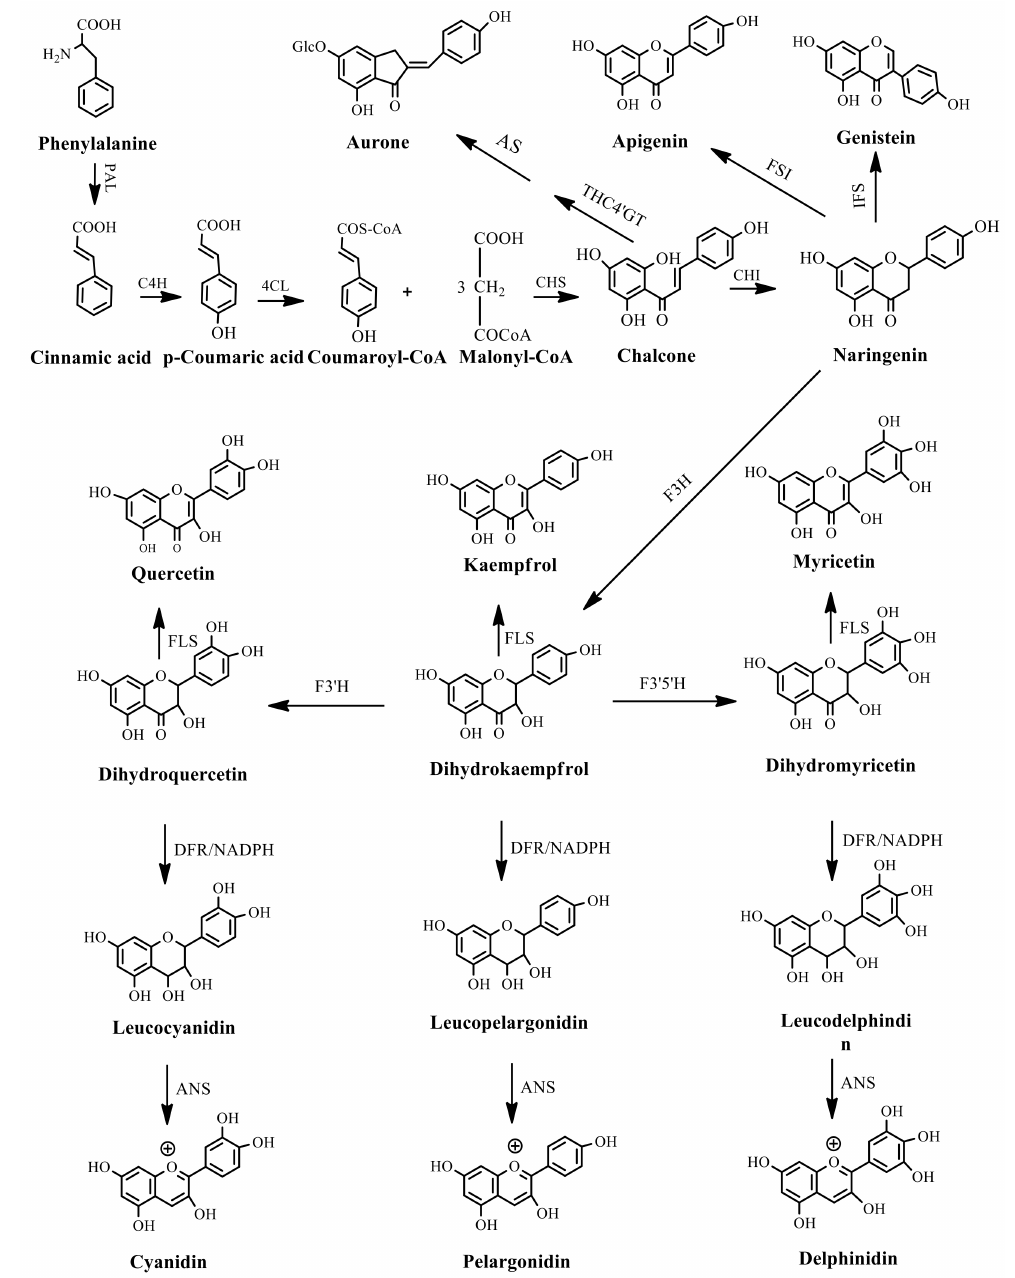
Figure 1. Classification and biosynthisis of flavonoids in plant (ANS = Anthocyanid in synthase; AS = Aureusidin synthase; C4H = Cinnamate-4-hydroxylase; CHI = Chalcone isomerase; 4CL = 4-coumaroyl: CoA-ligase; CHS = Chalcone synthase; DFR = Dihydroflavonol 4-reductase; F3H = Flavanone-3-hydroxylase; F3 (cid:48) H = Flavonoid 3 (cid:48) -hydroxylase; F3 (cid:48) 5 (cid:48) H = Flavonoid 3 (cid:48) 5 (cid:48) -hydroxylase; FLS = Flavonol synthase; FSI = Flavone synthase; IFS = Isoflavone synthase; PAL = Phenylalanine ammonia lyase; THC4 (cid:48) GT = UDP-glucose: tetrahydroxychalcone 4 (cid:48)